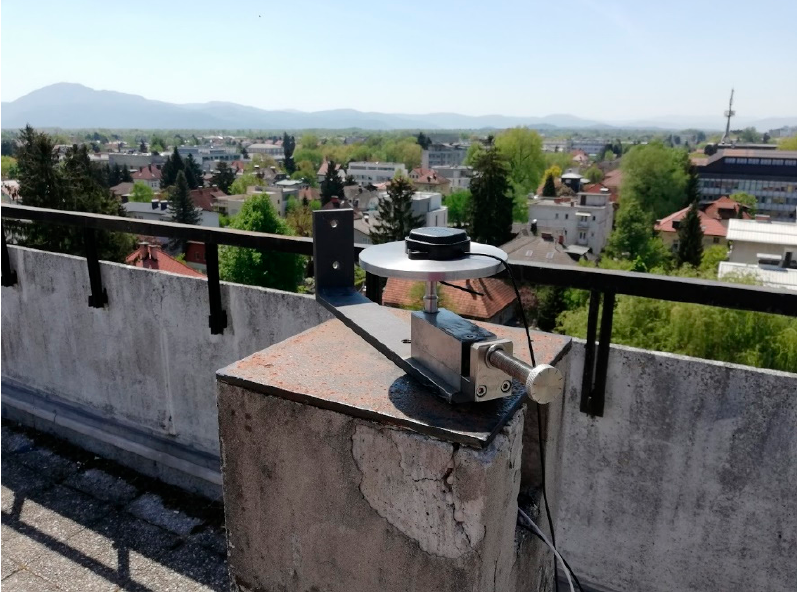
Figure 4. Specially constructed device for control movements and ground plane.